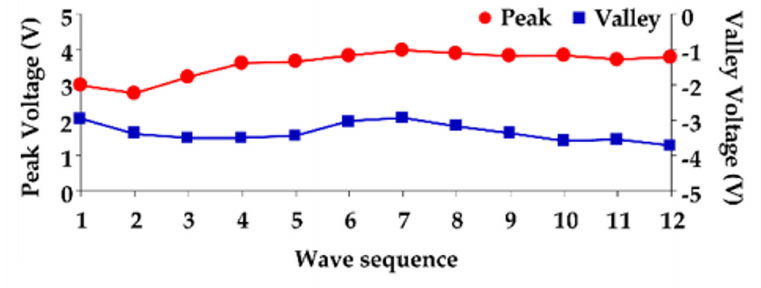
Figure 8. Peak and valley detection algorithm for PPW signals.